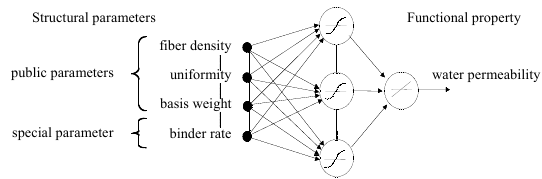
Fig. 6. Special model concerning water permeability for the chemical bonded family A general model is built using a neural network for all the nonwoven samples. It characterizes the relationship between the selected structural parameters and